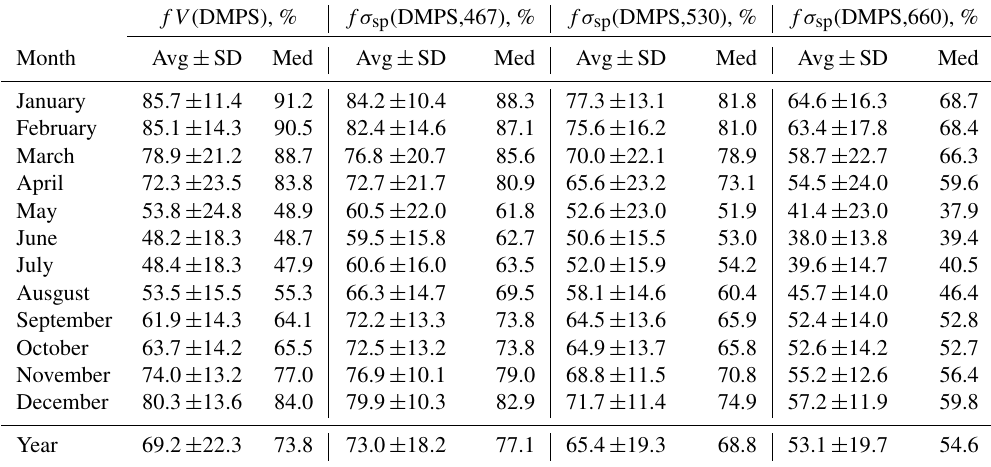
Table 1. Seasonal variation of the fractions of volume concentration f V (DMPS) (Eq. 3 in the text) and scattering coefficients f σ sp (DMPS) (Eq. 7 in the text) at wavelengths of 467, 530, and 660nm in the size range measured by the DMPS of the respective values calculated from the combined size distributions measured with the DMPS and the OPC at Dome C in December 2007–July 2009. Avg ± SD: average ± standard deviation; med: median. f V (DMPS), % f σ sp (DMPS,467), % f σ sp (DMPS,530), % f σ sp (DMPS,660),